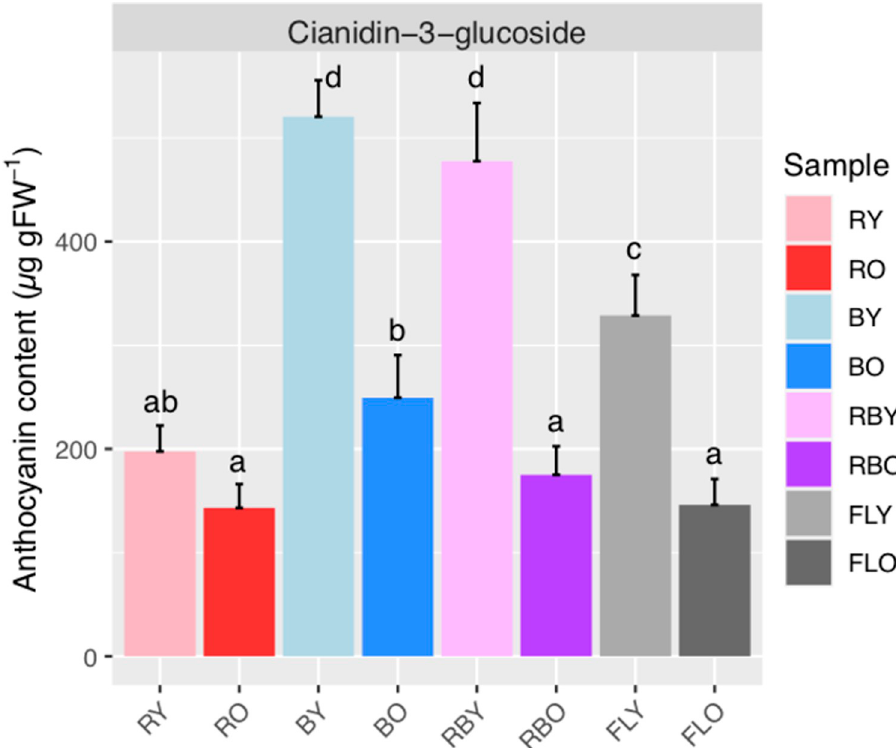
Fig 1. Anthocyanin content in the young (Y) and old (O) lettuce leaves grown under the red (R), blue (B), and red/ blue (RB) LEDs and the fluorescent (FL) light source conditions. Mean ± SD values for 5 replicate samples are shown. Different superscripts on the bars indicate a significant difference (p < 0.05) by ANOVA with Tukey’s HSD test. https://doi.org/10.1371/journal.pone.0265994.g001 within red LED and blue LED light samples in each leaf-age category. Although the contribution of the third axis (PC3, 4.3%) was small compared to those of PC1 and PC2, PC3 was the most highly correlated with the light source conditions (Fig 2B and 2C). Genes differentially expressed between young and old leaves Our comparison of the young and old leaves of plants grown under the different light condi- tions revealed that the number and composition of the DEGs depended on the light sources.